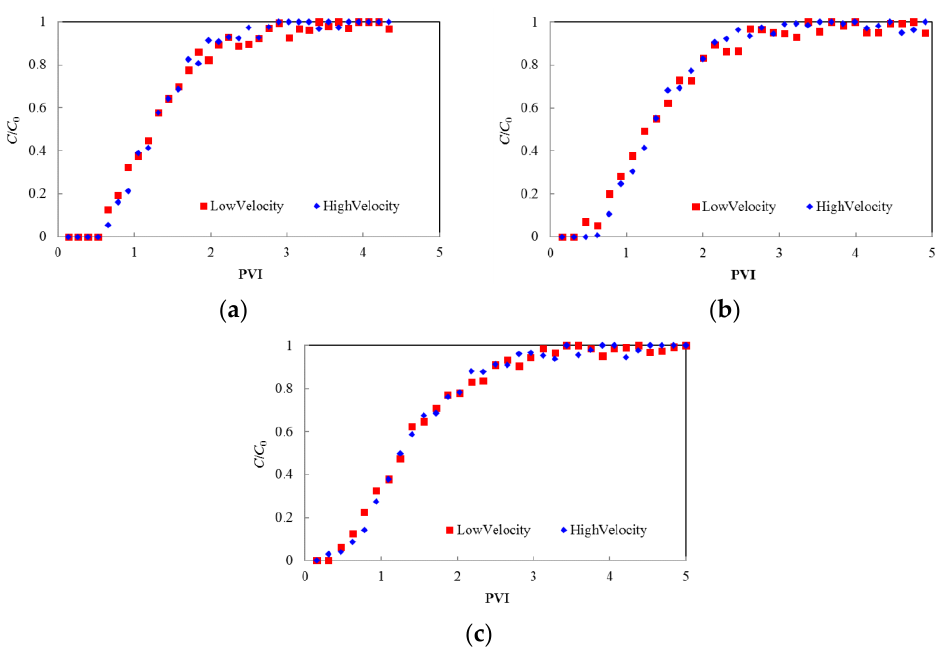
Figure 2. Tracer concentration ratio versus pore volume injected (PVI) at different flow rates in the natural cores (low rate = 0.02 cm 3 /s; high rate = 0.04 cm 3 /s): ( a ) core No. 1 (1570 mD), ( b ) core No. 2 (610 mD), and ( c ) core No. 3 (230 mD).